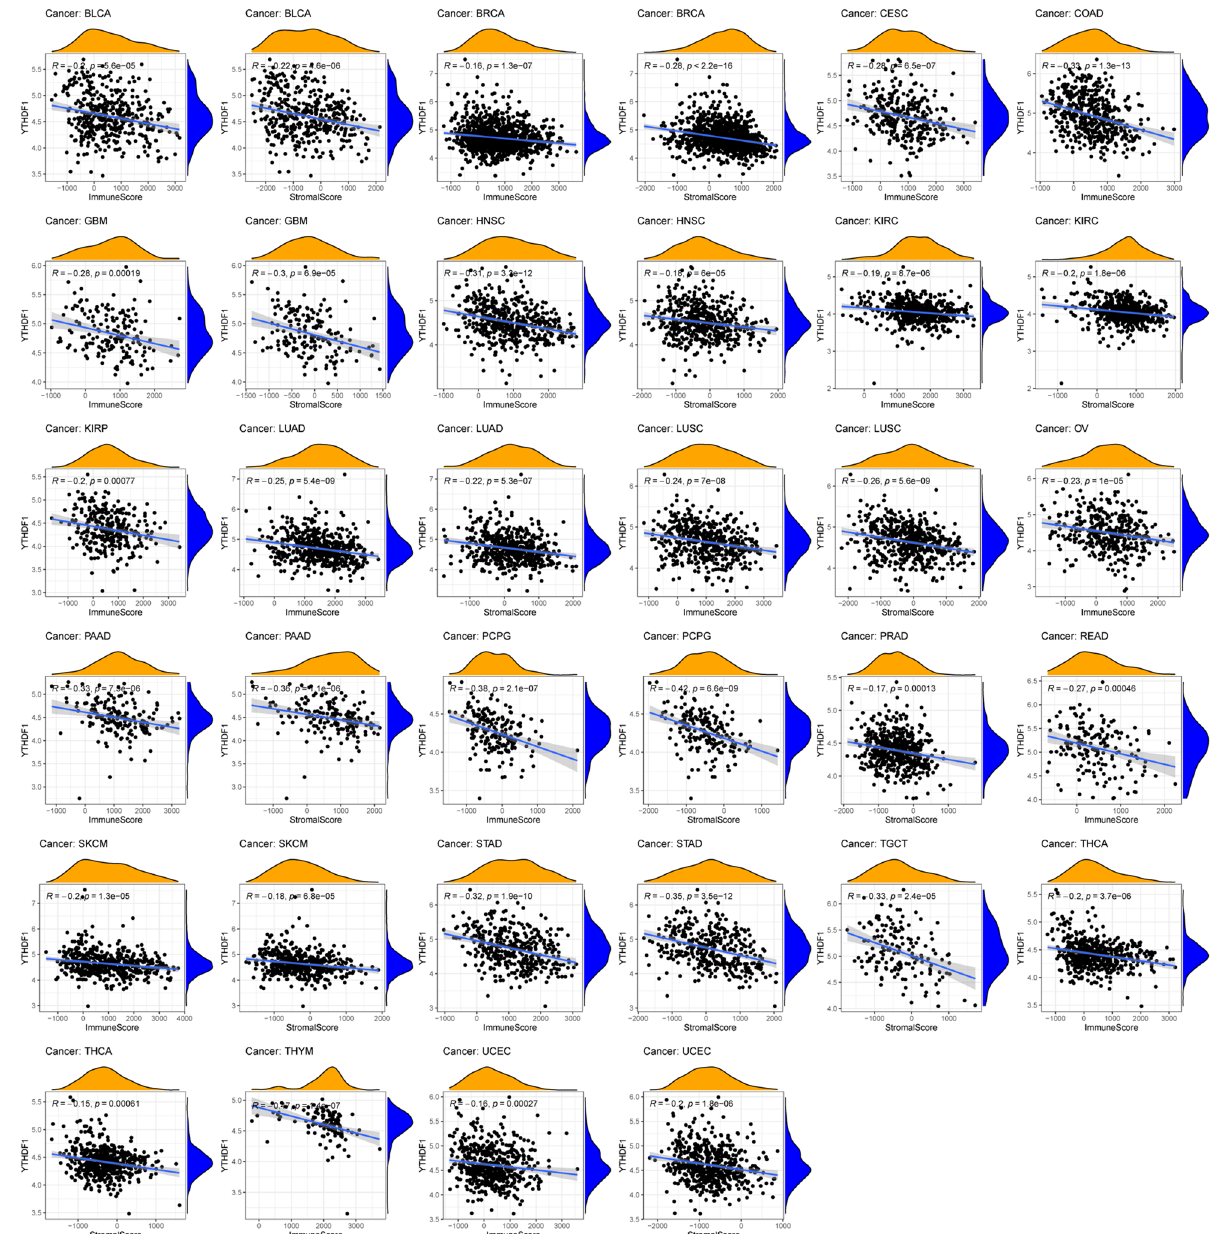
Figure 11. Correlation between YTHDF1 expression and immune and stromal score in